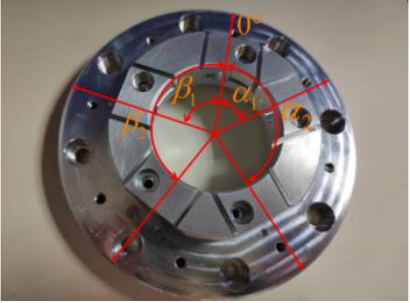
Figure 7. Measuring fixture.